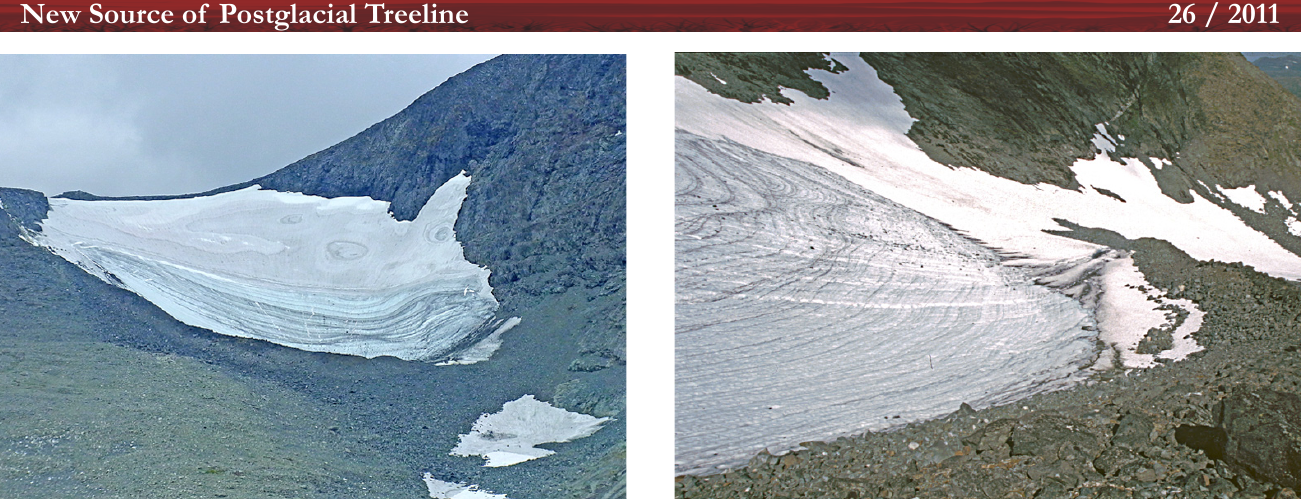
Figure 5: Left. Tempelglaciären (2) seen from the east. The lower terminus fringes an extensive frontal (Little Ice Age) moraine. 2009-09-10. Right. Close-up view of the tongue at the proximal side of the moraine, 1415 m a.s.l.